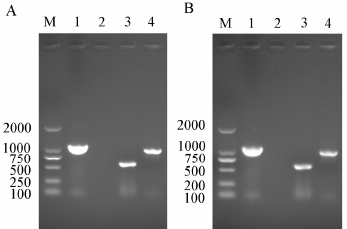
Figure 1. PCR detection of Rickettsia and Wolbachia in different Asia II 1 whitefly lines. ( A , B ): respectively, the PCR detection endosymbiont female and male in the I WR whitefly population; M: DNA marker; Lanes 1: positive control ( Portiera ); Lanes 2: negative control (ddH 2 O); Lanes 3: sequence fragments of Wolbachia wsp gene in the I WR whitefly populations; Lanes 4, sequence fragments of Rickettsia 16S rDNA gene in I WR whitefly population.